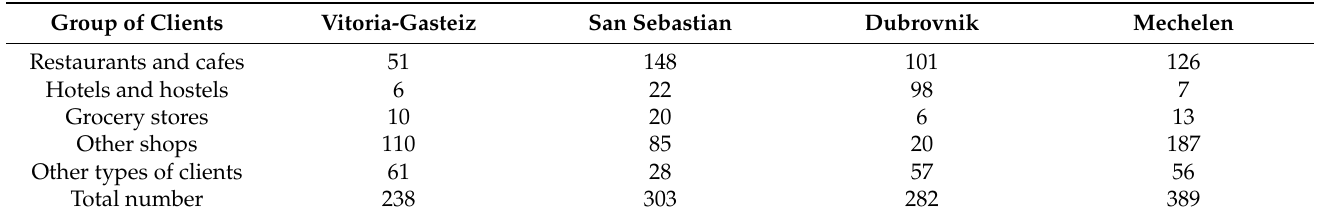
Table 1. Numbers of potential clients inside the studied areas of the CCCB partner